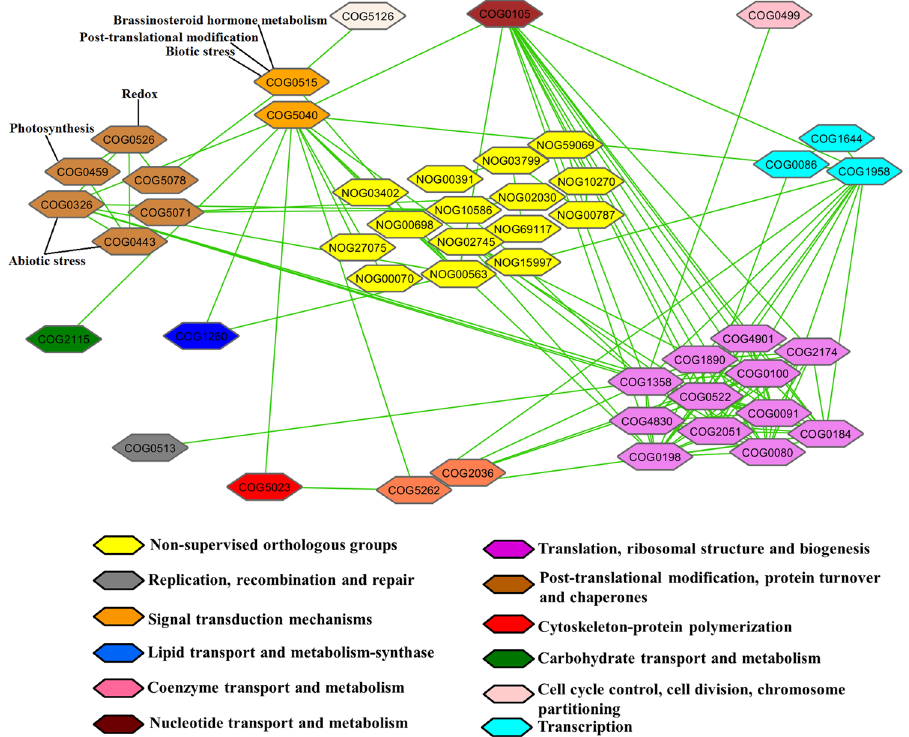
Figure 2. Protein-protein interaction network analysis (PPI) of core DEGs. PPI analysis was conducted using STRING (version 10.0, http://string-db.org, COG mode) and Glycine max as an organism (nearest neighbor legume in the organism list present in STRING database). The confidence score was set at ≥ 0.70 and co- expression and experiment parameters were chosen. COG descriptions along with color codes are mentioned in the